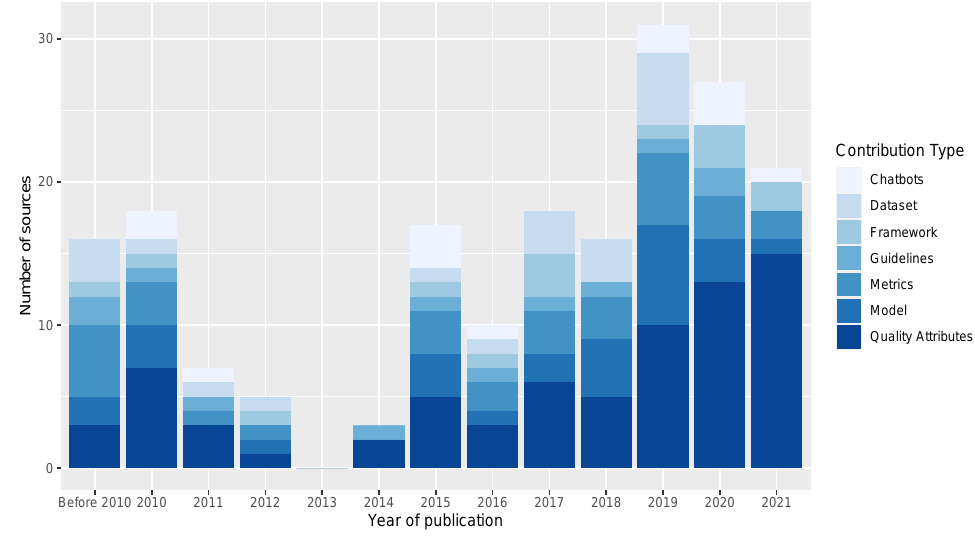
Figure 7. Number of white literature sources per year by type of